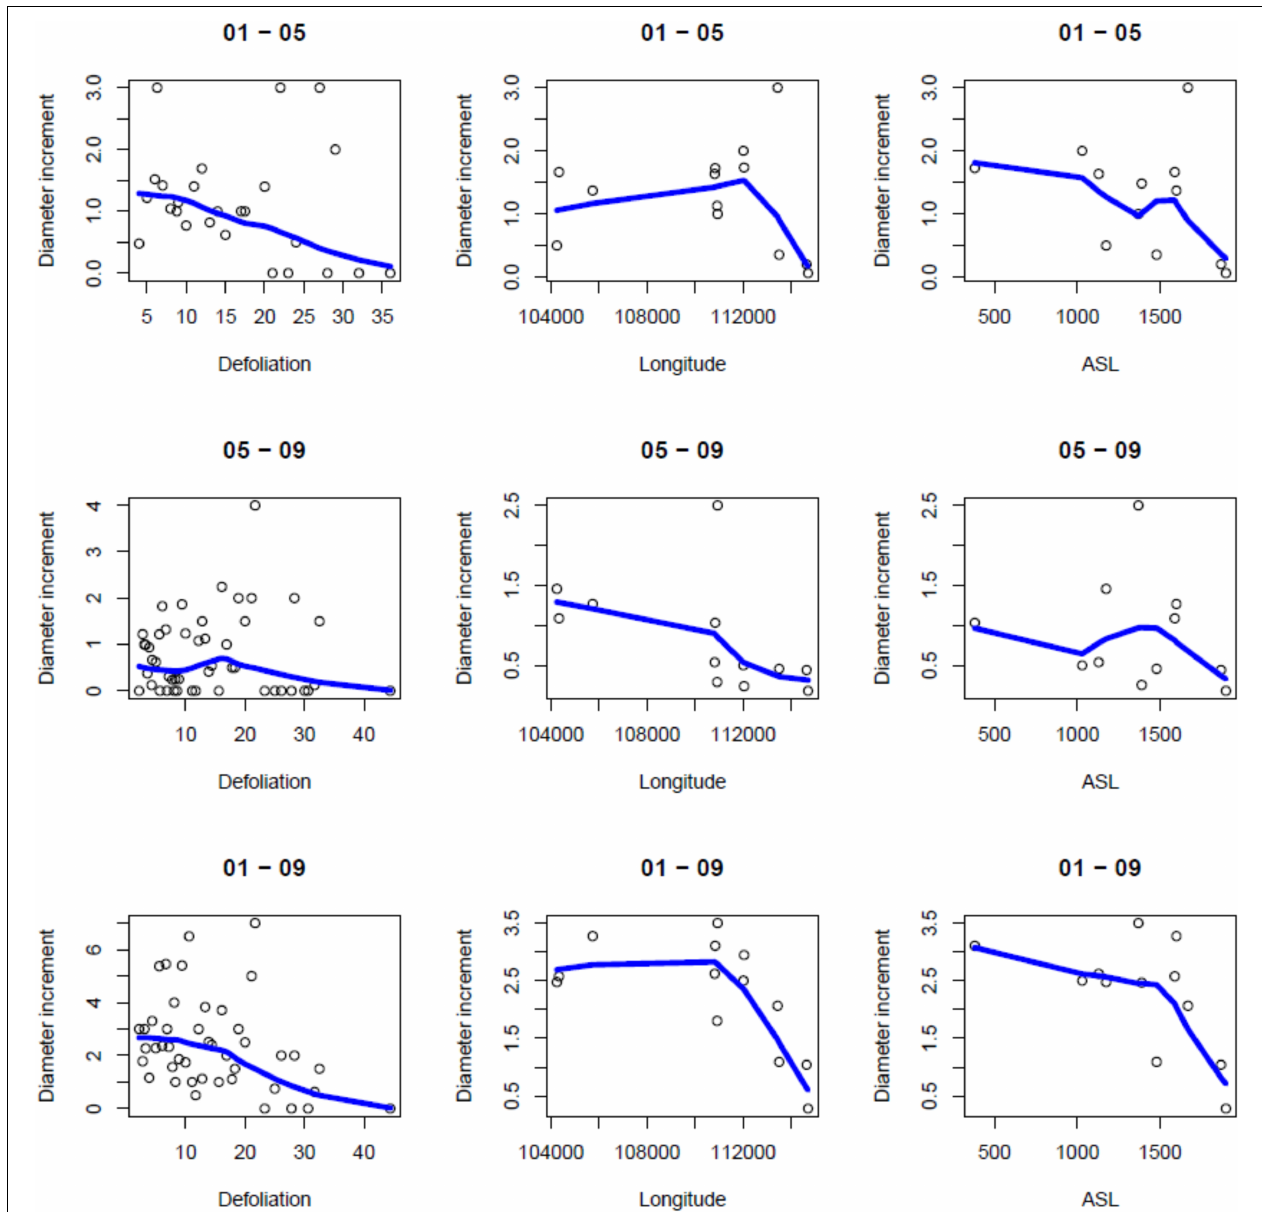
FIGURE 2 | Scatterplots of diameter increments (cm) for various values of defoliation (%), longitude (UTM Zone 32N, m) and elevation (ASL; m a.s.l.). Local linear regression curves are superimposed on the